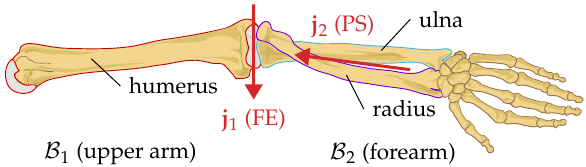
Figure 2. Anatomical model of the elbow joint. The humeroulnar joint is a hinge joint with the rotation axes j 1 , allowing for flexion and extension (FE). The radioulnar joint also has one degree of freedom ( j 2 ) and allows for pronation and supination (PS). In this contribution, we refer to the combined joint with two degrees of freedom as elbow joint